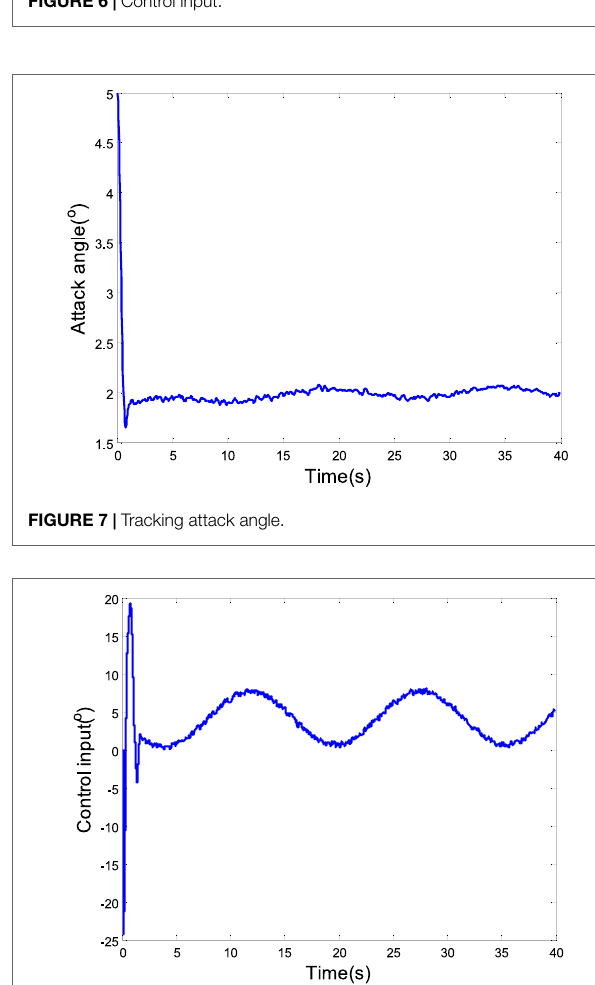
FIGURE 6 | Control input.